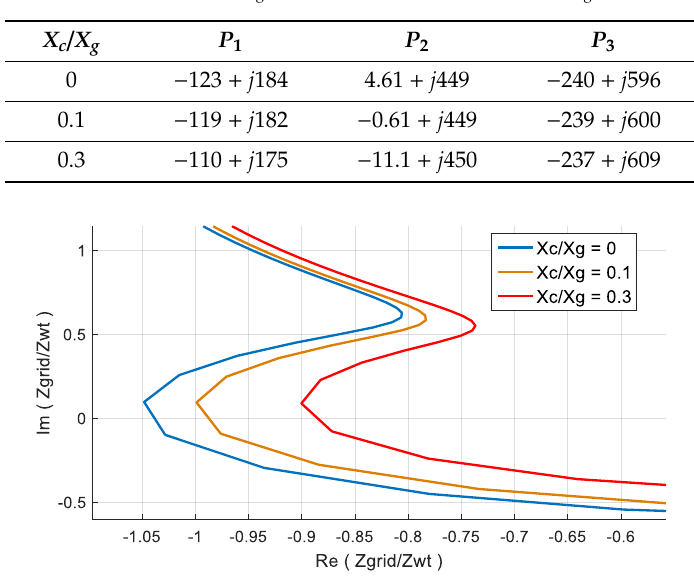
Table 3. Poles for X c / X g variations for SCR = 1.25 and X g / R = 20.